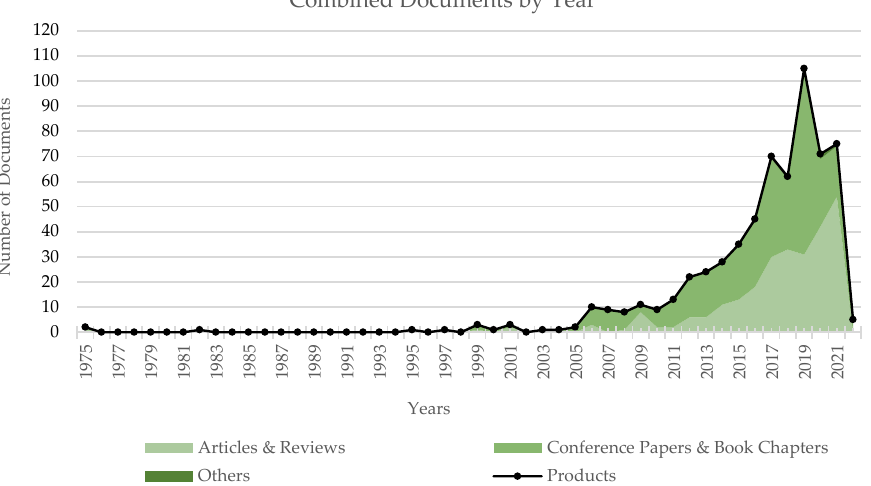
Figure 4. The distribution of the identified set of documents by year among combined categories of documents. Data are presented in stacked format. In the black line with dots is the total amount of documents by year. A significant production of conference papers on the subject started in 2006 and of journal articles in